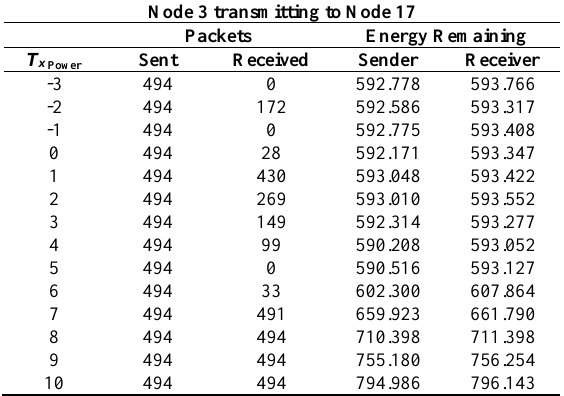
Table 13. Summary of the results under Scenario 2a (Node 3 to Node